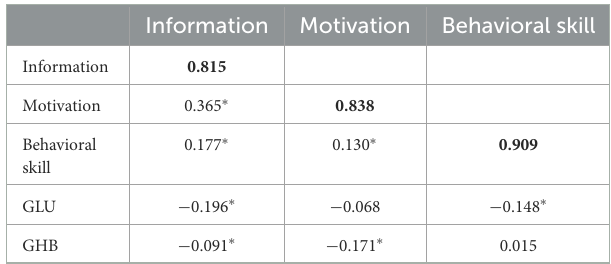
TABLE 5 Discriminant and criterion validity of 22-item DSMS.